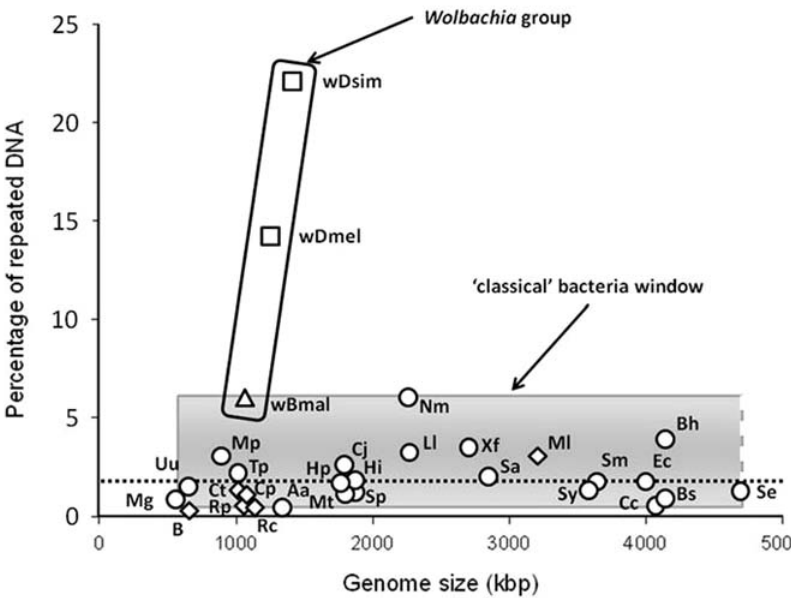
average of repeated Dna for prokaryotes (1.7 %). adapted from (Frank et al. ,